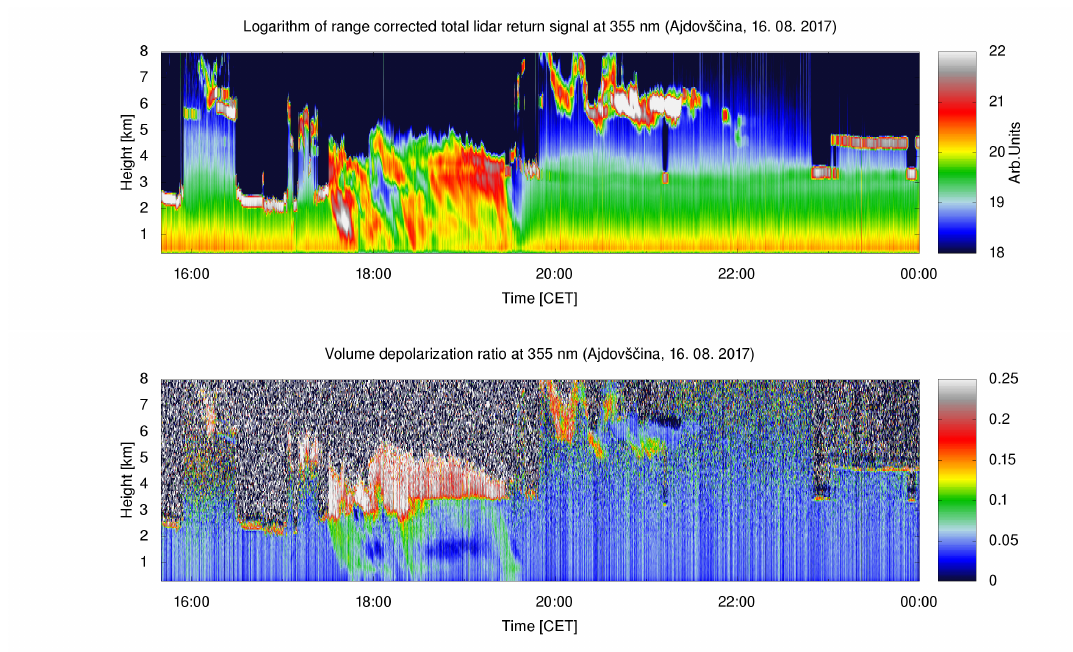
Figure 9. Temporal variation of the aerosol distribution over Vipava Valley on 16 August 2017 in terms of the 355-nm range-corrected LiDAR signal (top) and the volume depolarization ratio between the two polarized Mie–Rayleigh return channels (bottom). The data were resampled to a range resolution of 11.25m. The complete overlap range was above